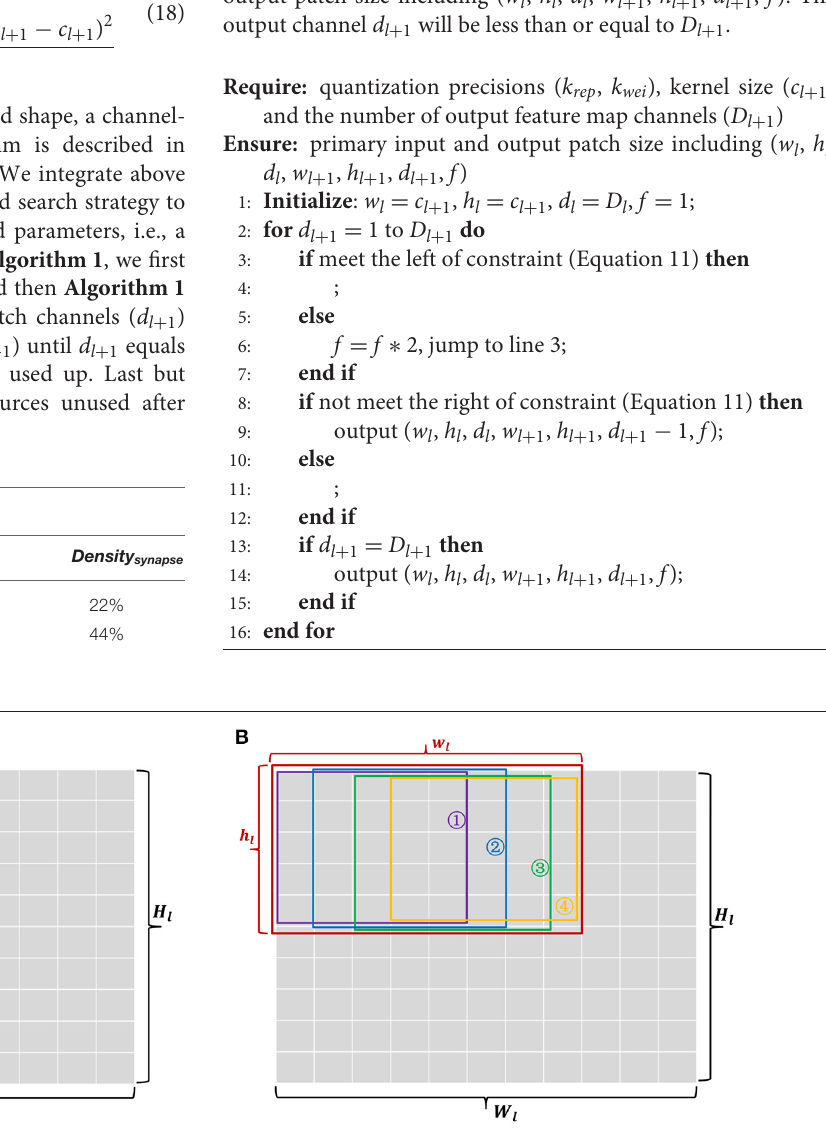
FIGURE 6 | Two kinds of input patches (A,B) which generate the same sized output patches. But the shape is square in (A) and rectangular in (B) . Each colored box denotes a 5 * 5 receptive field of convolution, except the red box that denotes a total input patch.